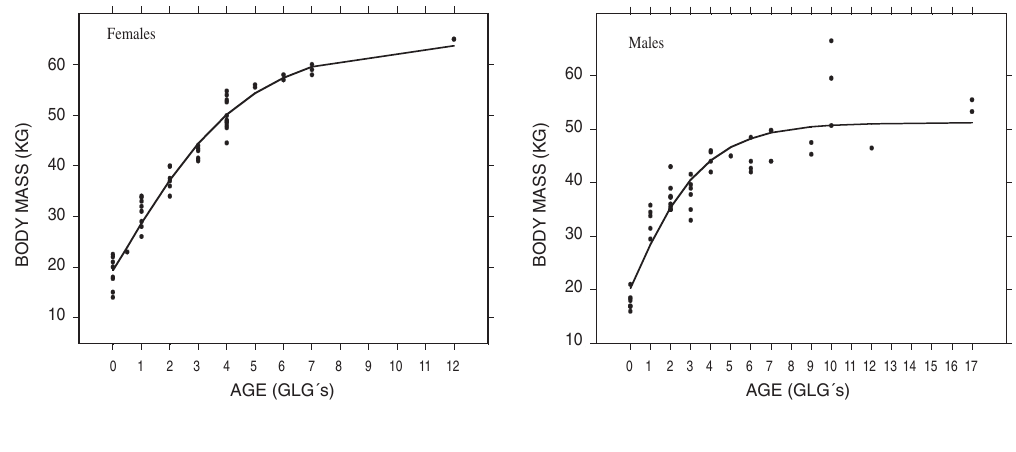
Fig. 6. Weight at age curves for female (a) and male (b) porpoises from 3 regions of West Greenland (1995) with fitted Gompertz growth curves. Females: n=46, W = 0.00028 L 1.713 G 30.782 . Males: n=55, W = 0.00008 L 1.570 G 31.212 .